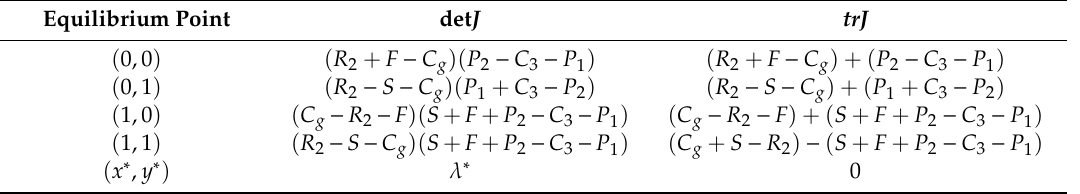
Table 3. The determinants and the traces of each equilibrium point.